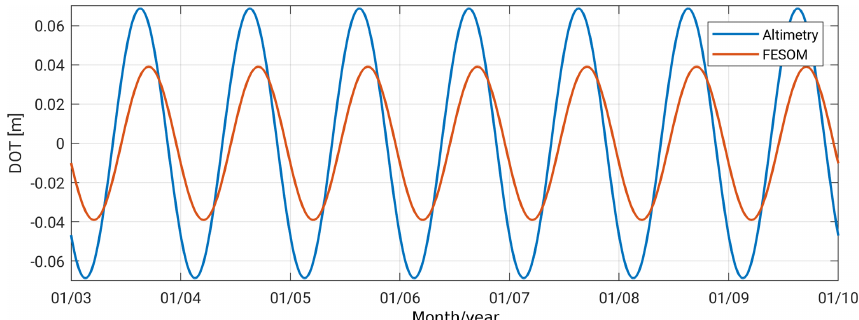
Figure 5. Annual cycles of DOT from along-track altimetry (blue) observations and FESOM (red) simulations within the investigation time and area (see Sect.